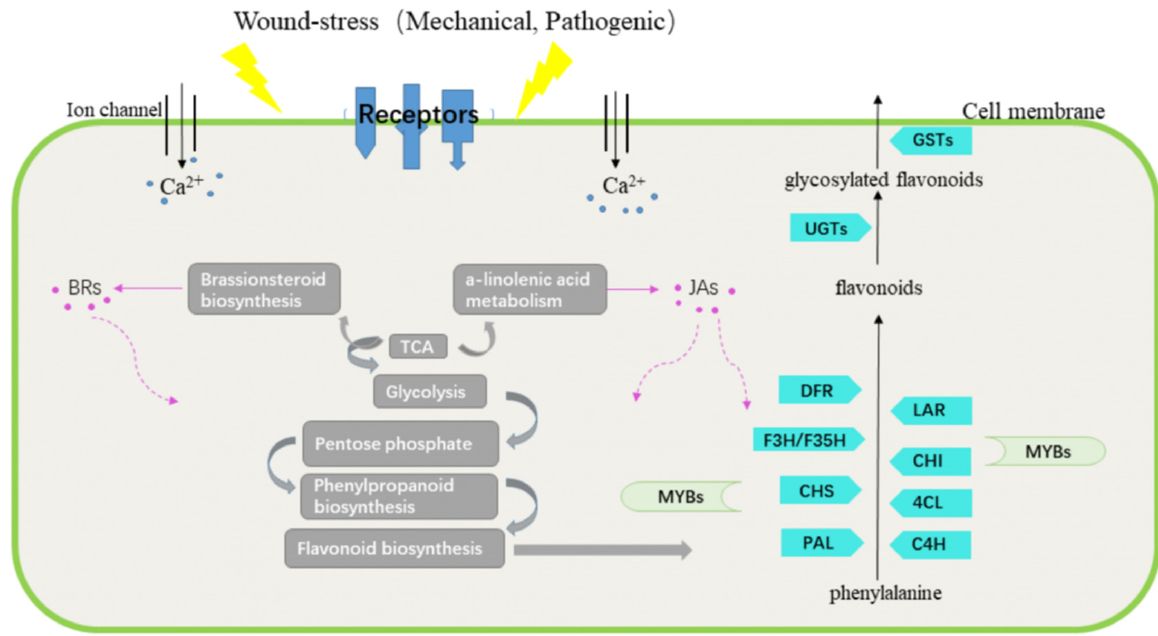
Figure 8. Inferred interplay of wounding and flavonoid biosynthesis in D. cochinchinensis.